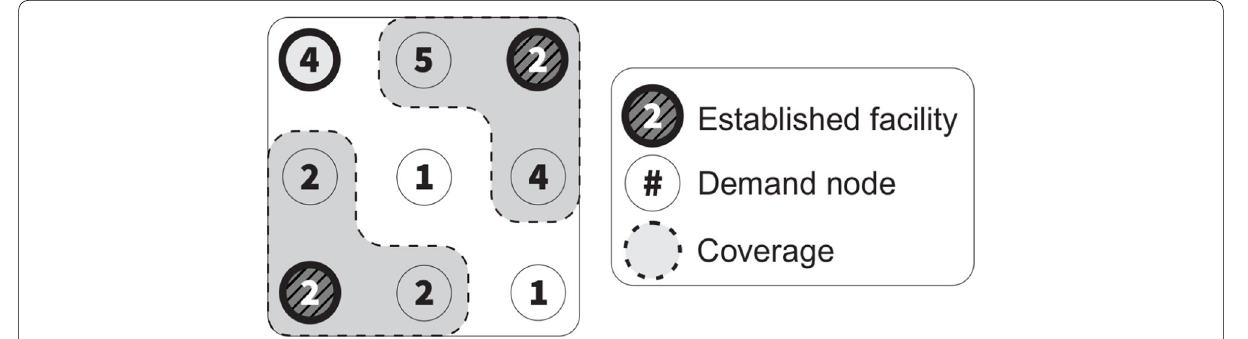
Fig.5 Optimal solution of the MCLP instance presented in Fig. 2 ( p = 2